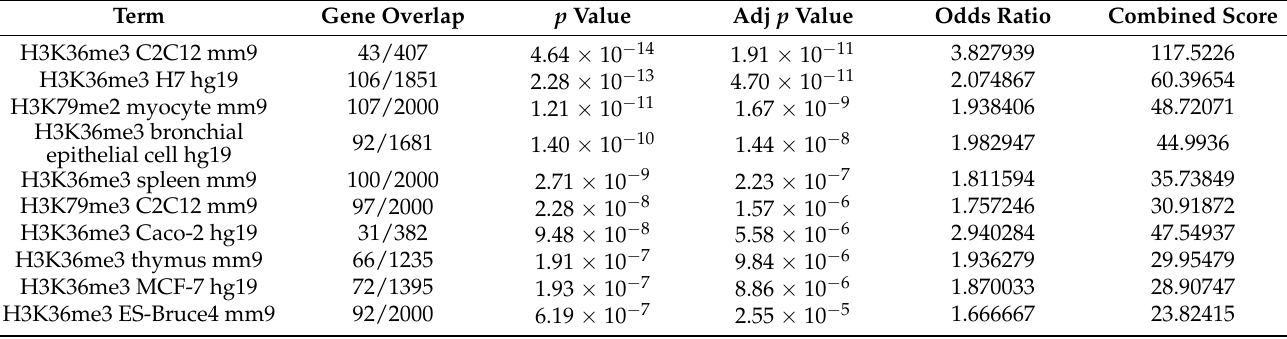
Figure 1. Venn diagram of differentially expressed genes between the CPT-CEF-treated and untreated HT29 colon cancer cells. The differentially expressed genes were calculated using DESeq2 and categorized based on underexpression, overexpression, and unchanged expression. The cut-off values of p < 0.1 and fold change > 2.0 (unchanged < 2.0) were used. The thematic association of altered gene expression patterns to epigenetic mechanisms was uncovered through ORA using Enrichr. Both the upregulated and downregulated genes were used to search the Enrich database for the ENCODE Histone Modifications database. This provided information for identifying the associations with the genes involved in the histone modifications (Table 1). In total, 40 DEGs involved in histone modifications were identified through ORA. The computational search for histone modifications that could regulate the transcriptional patterns resulted in the identification of genes related H3K4mc3), H3K79 (H3K4me2), H3K56 (H3K56H1 and H3K56ac1.1), H2BK120ac 1, and H4K91ac 1 (Figure 2). Table 1. A list of the top 10 terms was obtained using over-representation analysis via Enrichr and the ENCODE Histone Modifications gene set library.